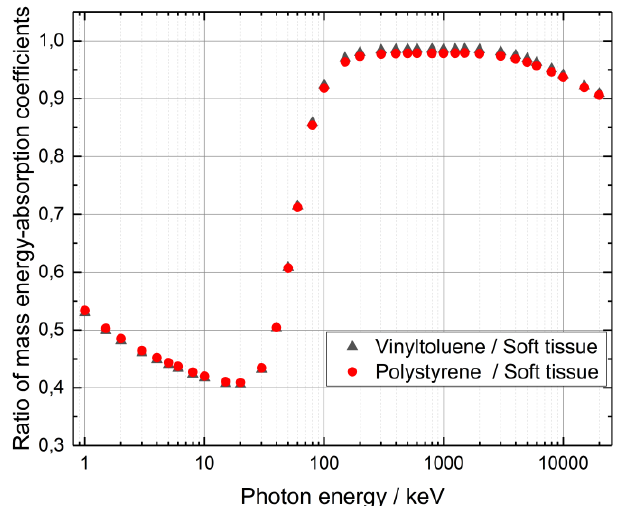
Fig. 1. Comparison of mass energy-absorption coefficients of the main polymer bases of plastic scintillators with the same for ICRU 4-component soft tissue [10].